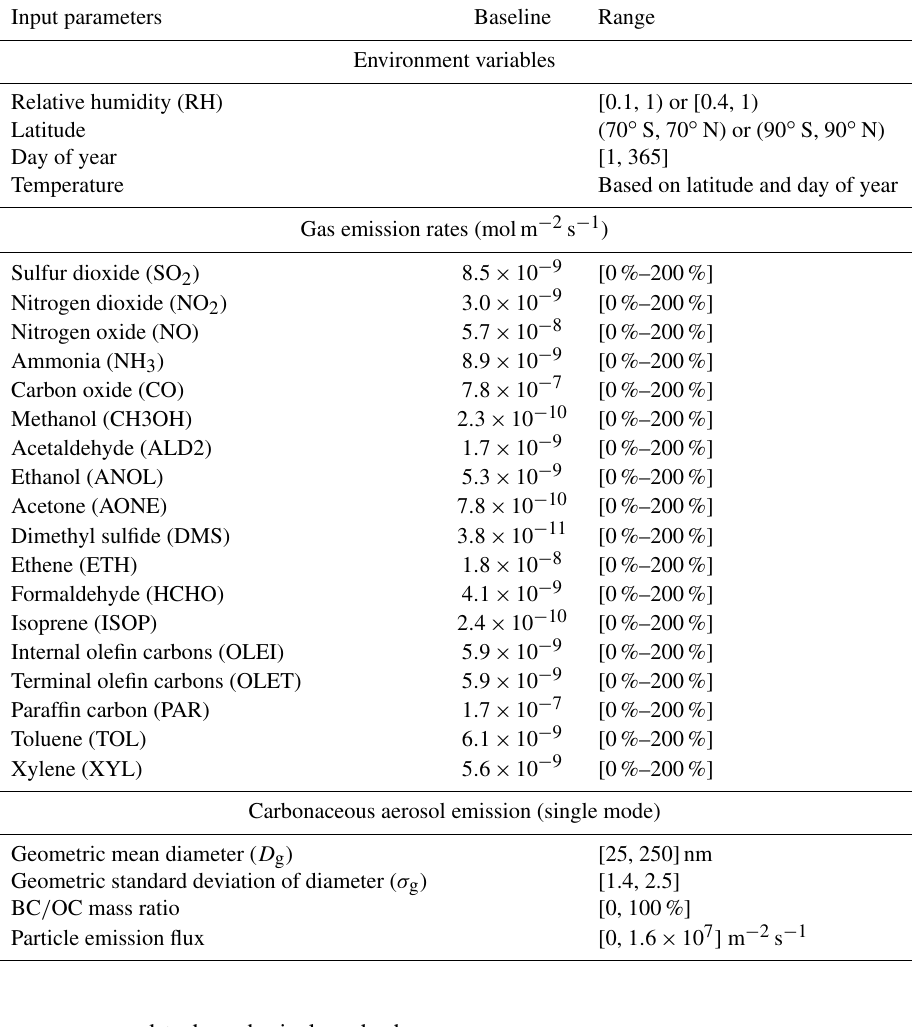
Table 1. Baseline and range for the input